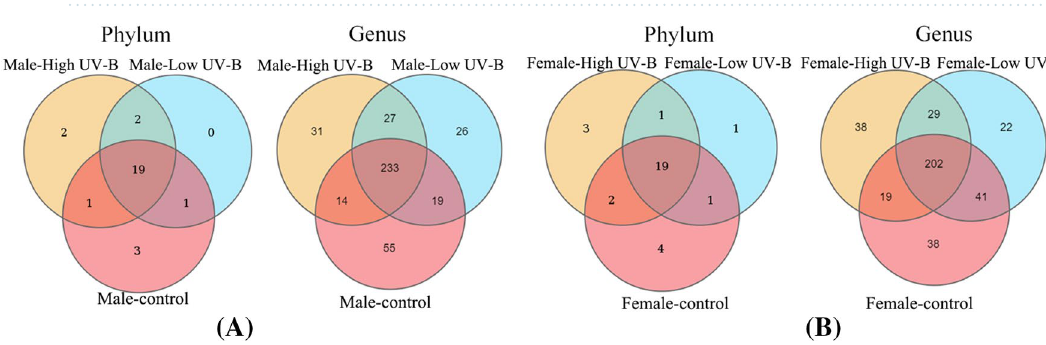
Figure 6. Venn diagram of epiphytic bacteria of S. thunbergii under increased UV-B radiation, ( A ) male S. thunbergii , and ( B ) female S. thunbergii (A mean ASV tag number less than 1 in a group indicates that there were no ASV species in that